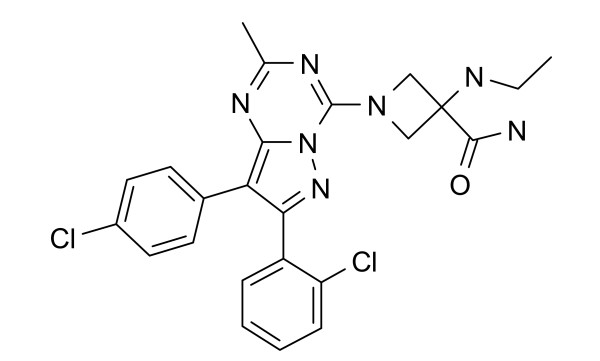
Structure of CE-178253.